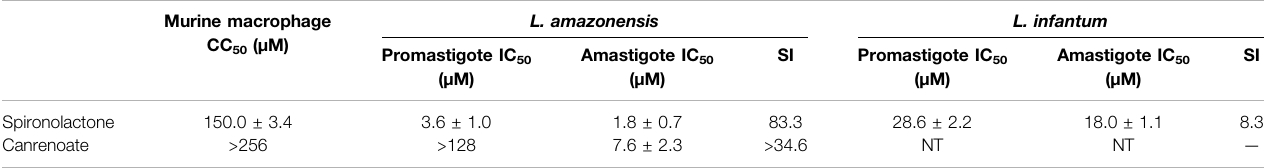
TABLE 1 | IC 50 values for spironolactone and metabolite canrenoate on L. amazonensis and L. infantum promastigotes and intracellular amastigotes and CC 50 values for murine peritoneal macrophages and the selectivity index (SI). Murine macrophage CC 50 (µM)